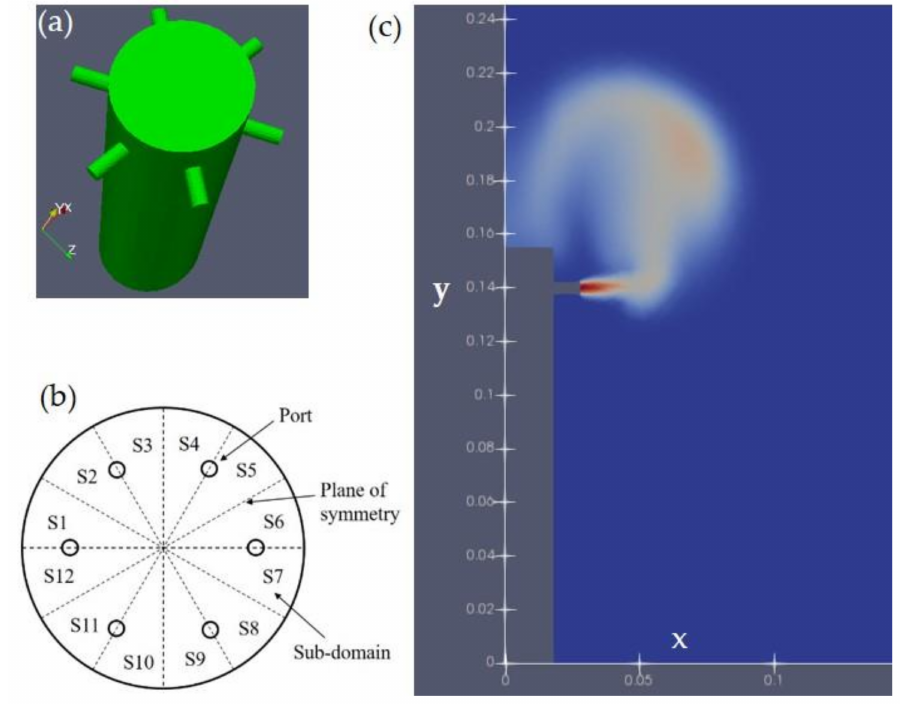
Figure 1. Schematic of a rosette-type diffuser ( a ), the sub-domains ( b ), and the coordinate setup ( c ). The data of rosette-type buoyant jets obtained by experiment [11] and simulation were shown in Figure 2. In this figure, the comparison of the measured and simulated data. The root-mean-squared error (RMSE) for the normalized concentration was 0.25,